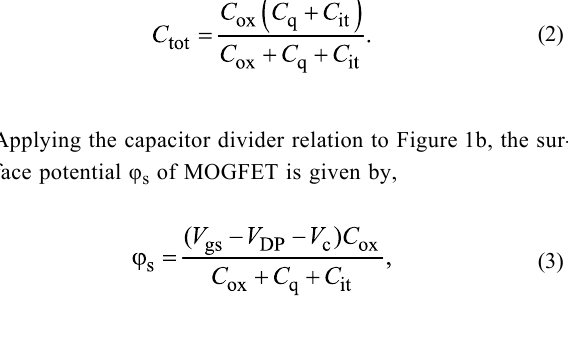
is the Planck’s constant, v f is the fermi velocity (1 × 10 8 cm 2 /(V·s)), C qi is a fitting factor independent of φ s , and accounts for the finite C q observed at Dirac point (DP) (at which the fermi level E f = q φ s = 0 = E D , where E D is the energy (eV) at